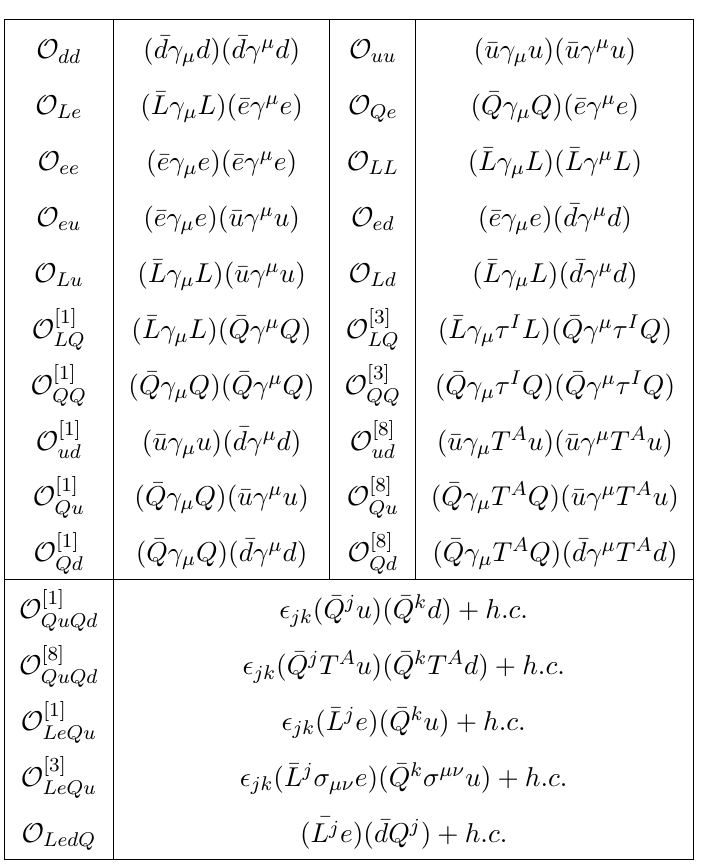
Table 11. 2HDM: Baryon Number Conserving 4 [20 + 5 are SU(2)